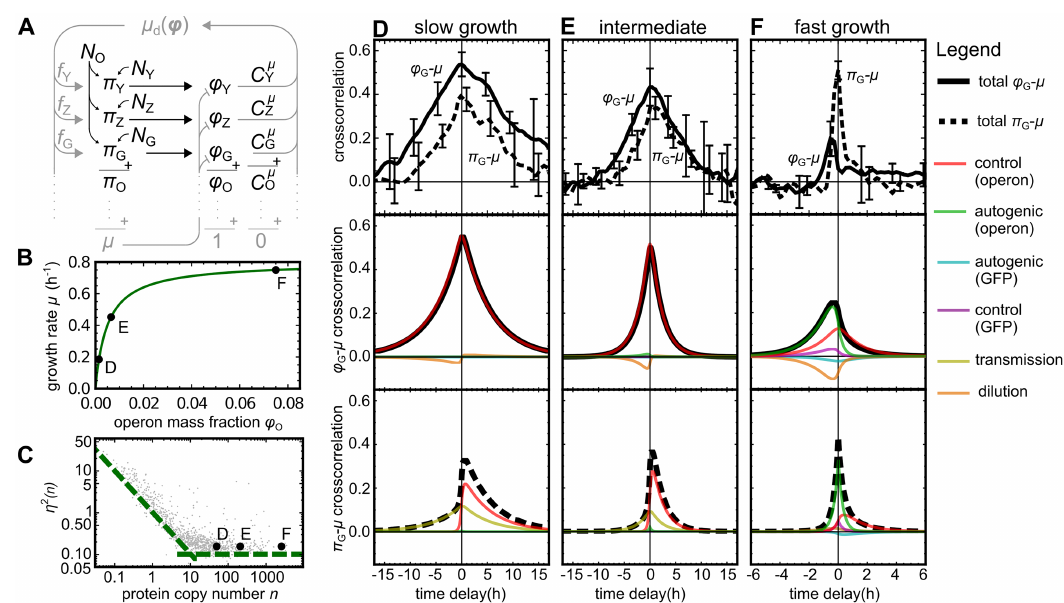
Fig 4. Expression–growth cross-correlations in the many-protein model. ( A ) Cartoon of the noise propagation network. ( B ) Monod curve describing the mean growth rate as a function of lac expression. Black dots indicate the operon mass fractions and growth rate used to calculate the cross-correlations in (D)-(F). ( C ) Noise distribution of the proteome (gray cloud) taken from Ref. [51], and the values chosen for proteins on the lac operon (black dots). Green dashed lines are guides for the eye. ( D )–( F ) Experimental [5] (top panels) and theoretical (middle and bottom panels) cross-correlations for three growth conditions. Proteome fraction–growth and production–growth cross-correlations are plotted as solid and dashed black lines, respectively. As in Fig 3A and 3B, colored lines show the contributing noise